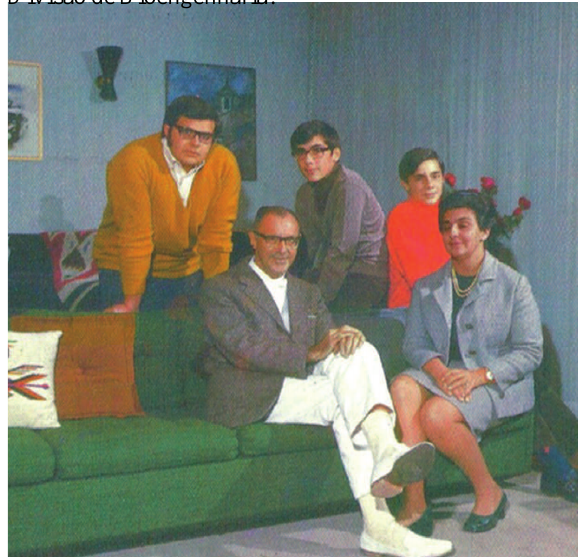
Fig. 11 – Dr. Zerbini e Dra. Dirce com os filhos Roberto, Eduardo e